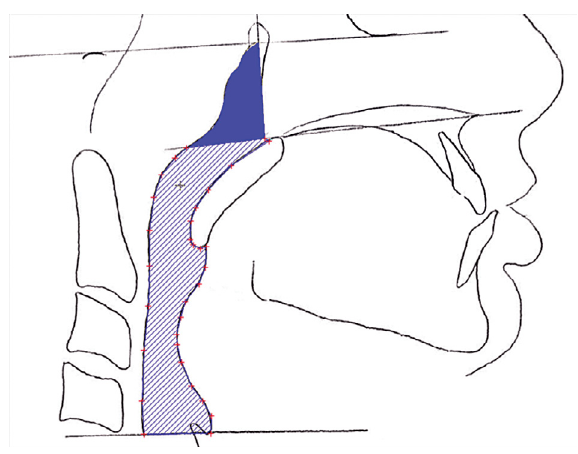
Figure 3. Nasopharyngeal (NA, blue section), oropharyngeal (OA, striped section)